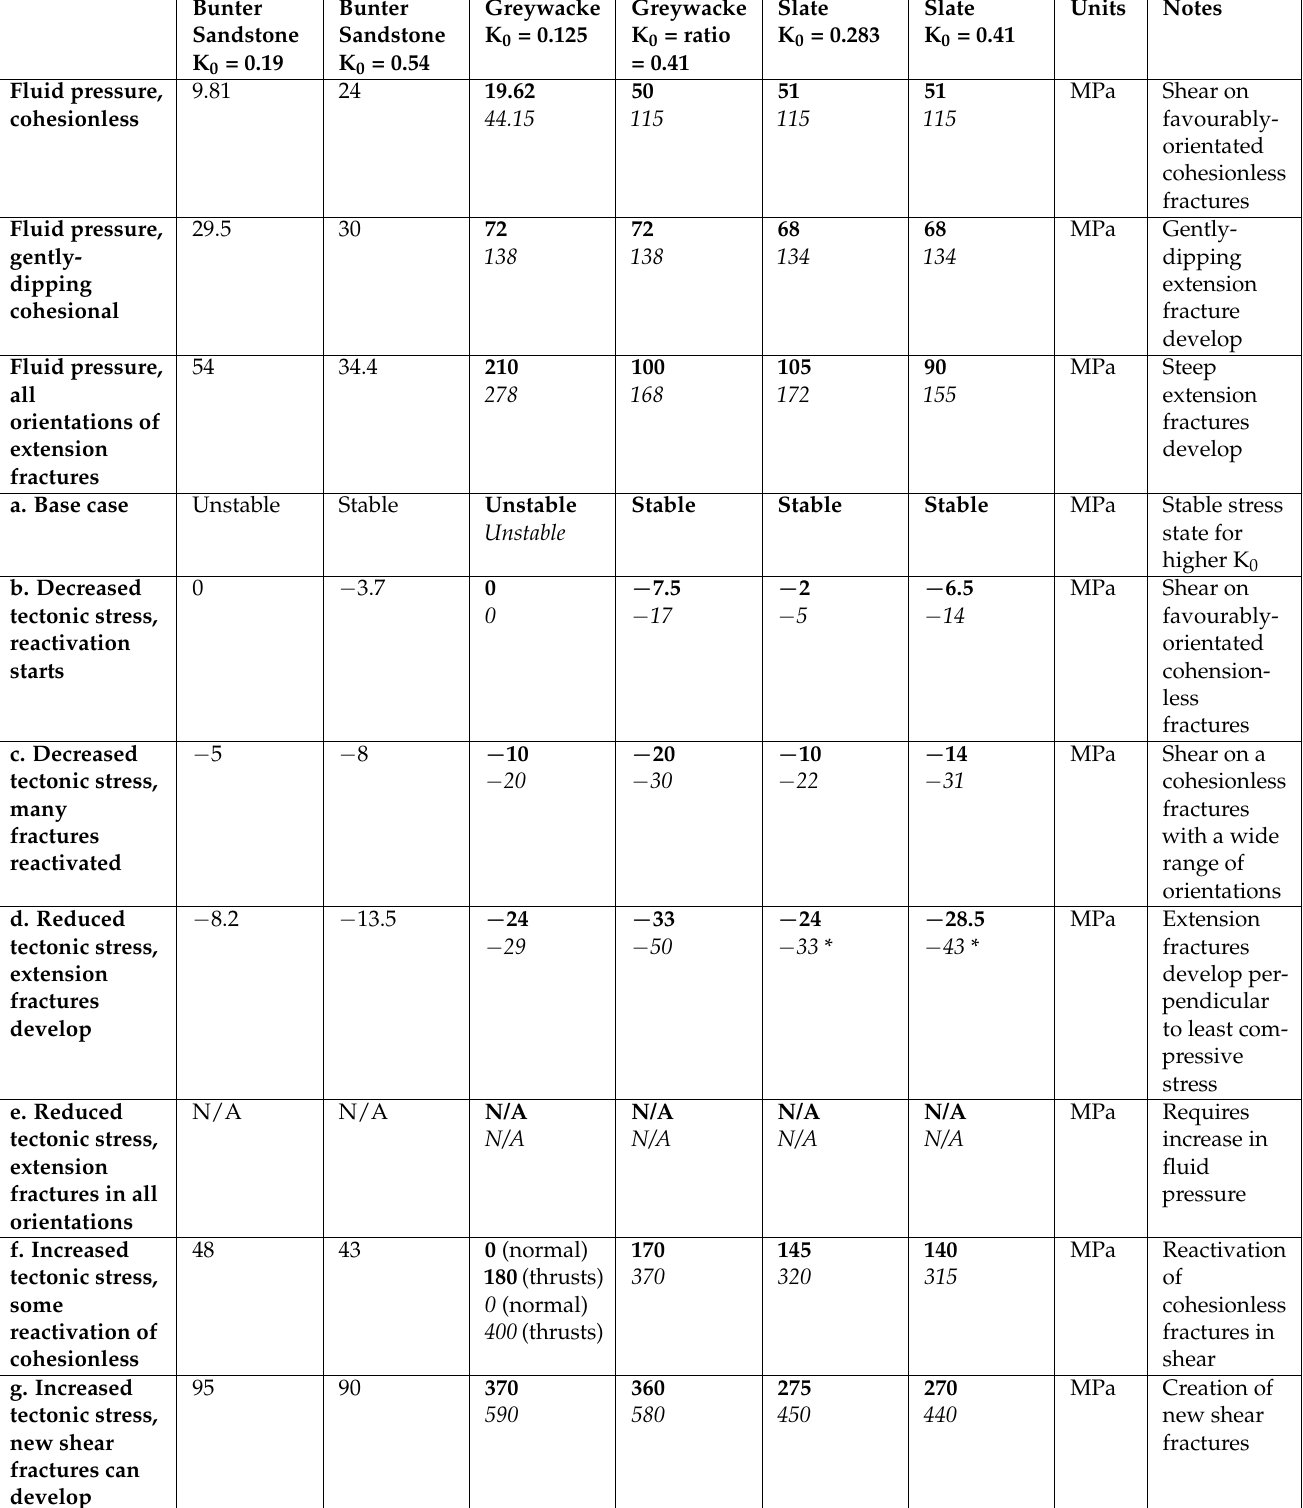
Table 4. Results of the modelling for the Bunter Sandstone and the Lower Palaeozoic greywackes and slates, showing the calculated critical values. Values specific to a modelled depth of 2 km are shown in bold, and values specific to a modelled depth of 4.5 km are shown in italics. * Shear or hybrid fractures, rather than extension fractures, may develop in the slates under these